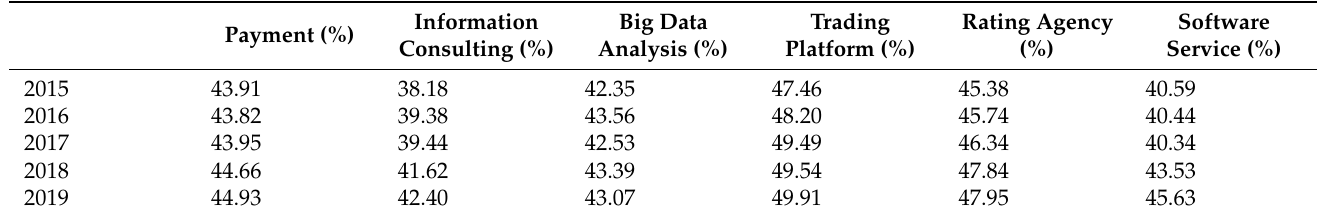
Table 14. The annual changes in the similarity of risk factor contents in different fintech